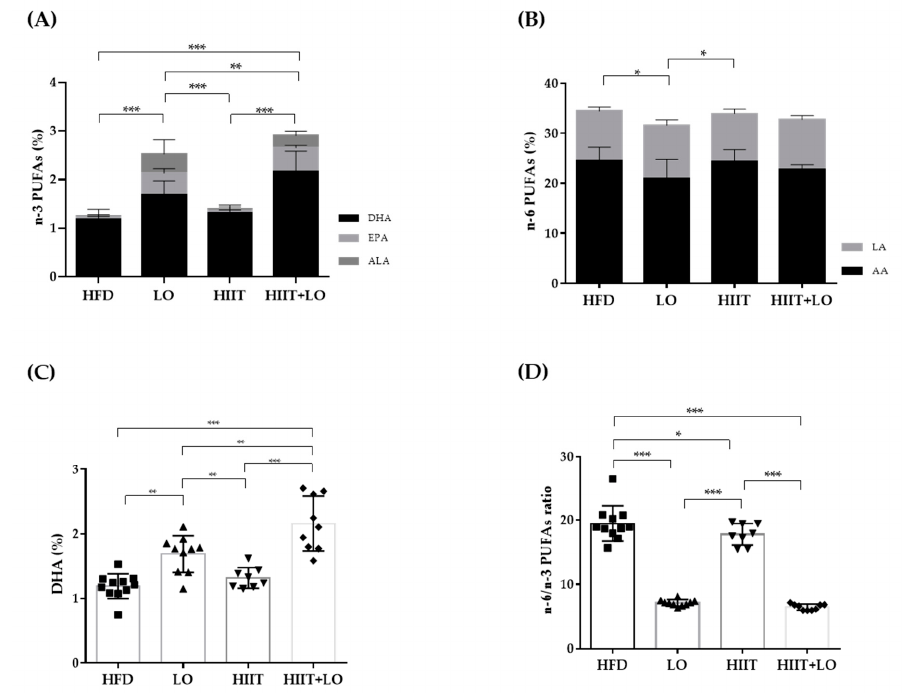
Figure 3. Fatty acid composition in erythrocytes from the four groups: HFD ( n = 12), LO ( n = 11), HIIT ( n = 8), and HIIT+LO ( n = 9). ( A ) n-3 PUFAs (% of total fatty acids), and ALA, EPA, and DHA distribution (%) in erythrocytes. ( B ) n-6 PUFAs (% of total fatty acids), and LA and AA distribution (%) in erythrocytes. ( C ) DHA (%) in erythrocytes. ( D ) n-6/n-3 PUFAs ratio in erythrocytes. * p <